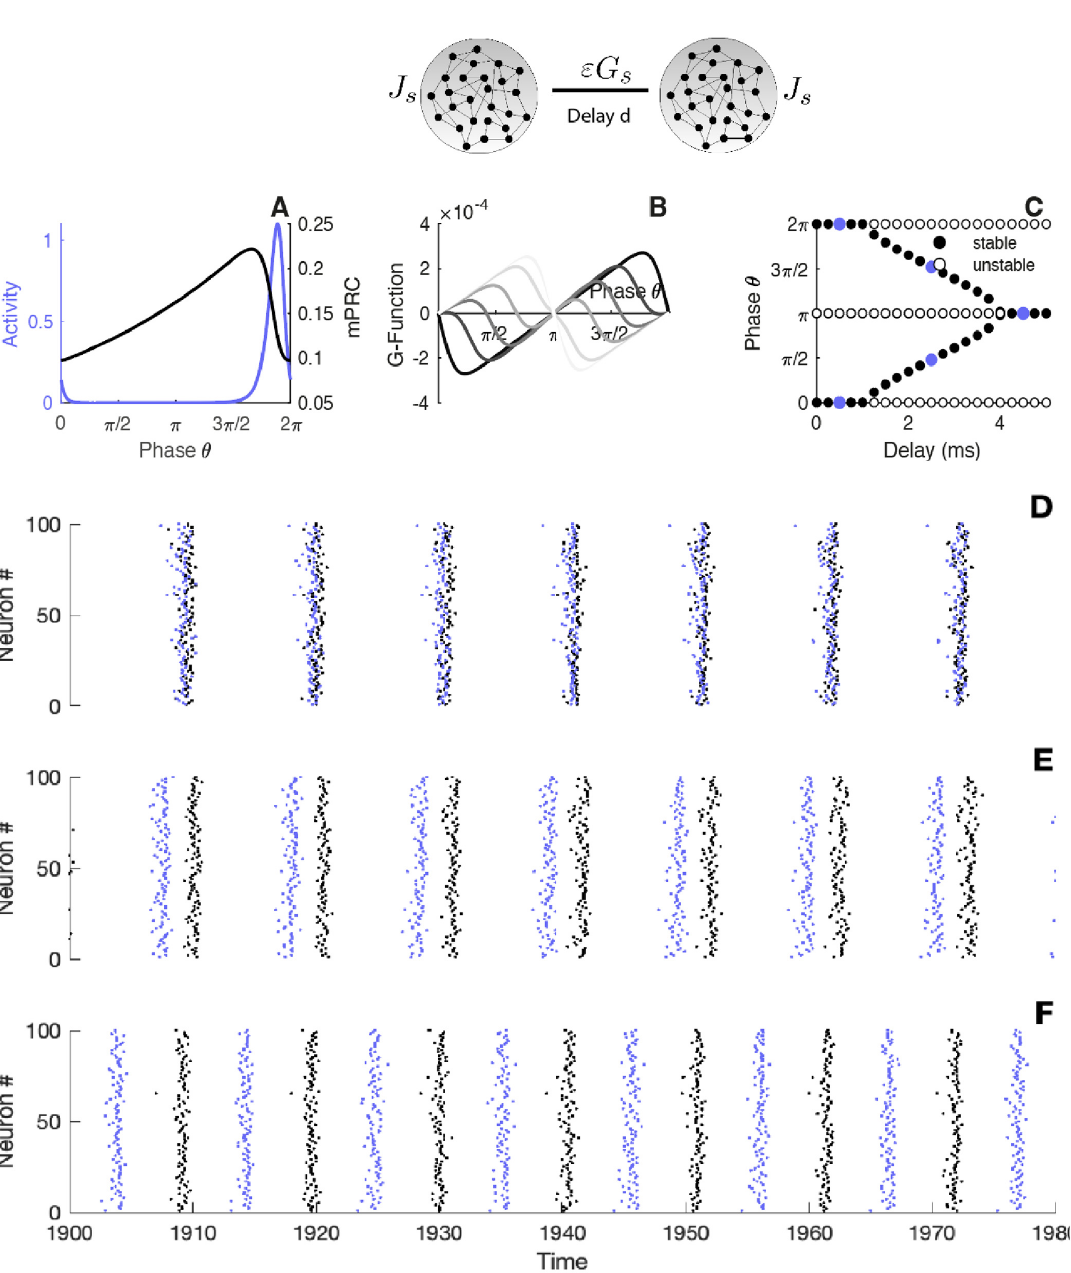
represents the coupling s ) (1 − exp( − ( r − ref